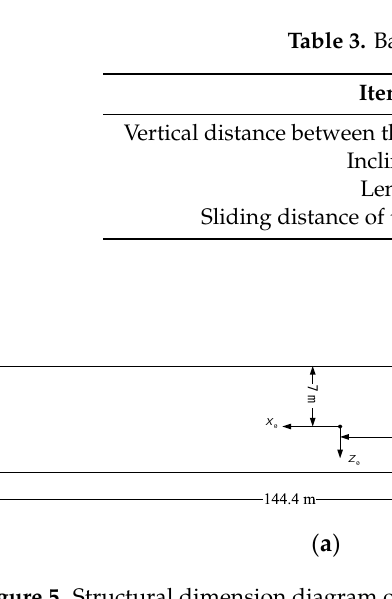
Figure 5. Structural dimension diagram of the ship and boat: ( a ) the size of the longitudinal section in the center plane of the ship and skid; ( b ) the inclination of the skid and the position of the boat at the skid.